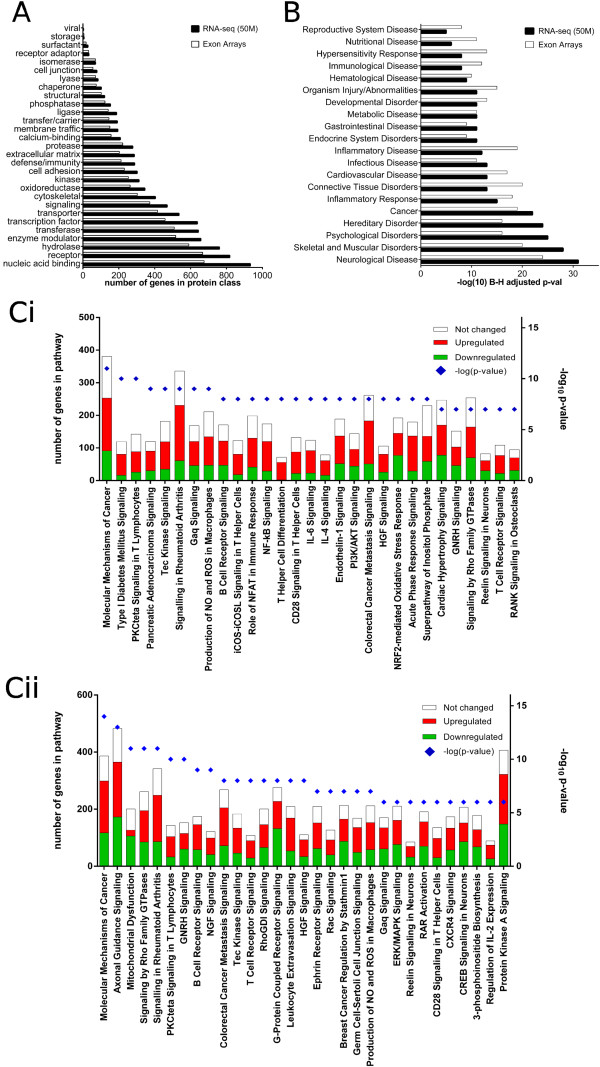
Functional analysis of differentially expressed genes after SNT as determined by RNA-seq (50 M) and exon arrays. A) Distribution of DE genes according to respective protein classes is similar for both datasets. B) Top Biological Functions/“Diseases and Disorders” assigned to DE genes largely overlap between the two datasets. Ci, Cii) Statistically overrepresented “canonical pathways” rank differently between the datasets, with top pathways in exon arrays being mostly related to immune function (Ci), while in RNA-seq, neuronal pathways are more represented (Cii).